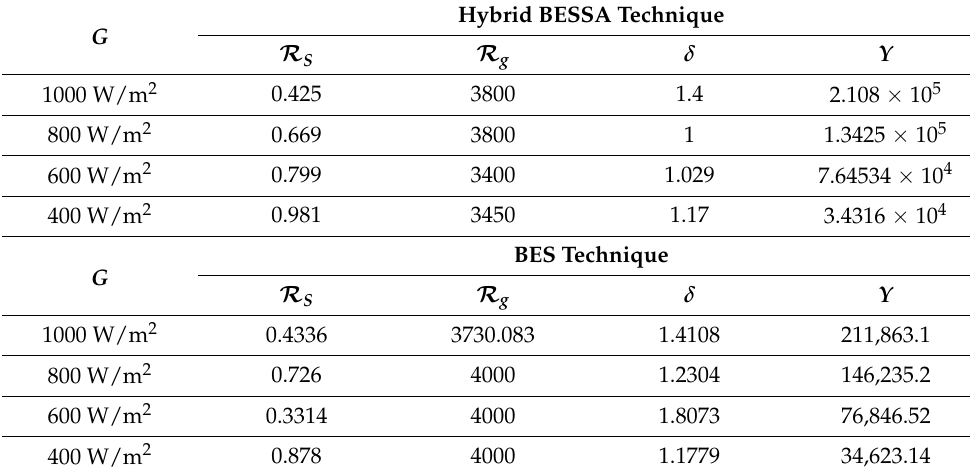
Table 10. Parameters of the PV Module AS-M3607-S (G1 CELLS) extracted using the Hybrid BESSA and BES techniques with G varying from 400 W/m 2 to 1000 W/m 2 while keeping T fixed at 25 ◦ C. G